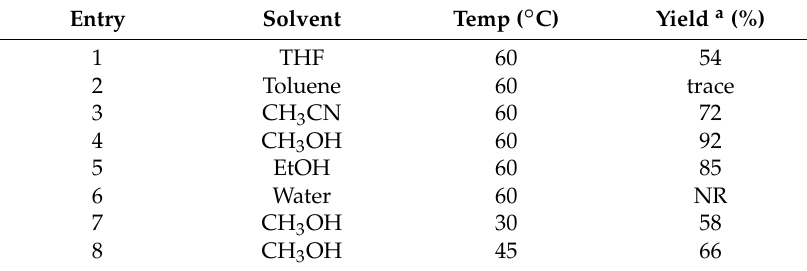
Table 1. Optimization of reaction